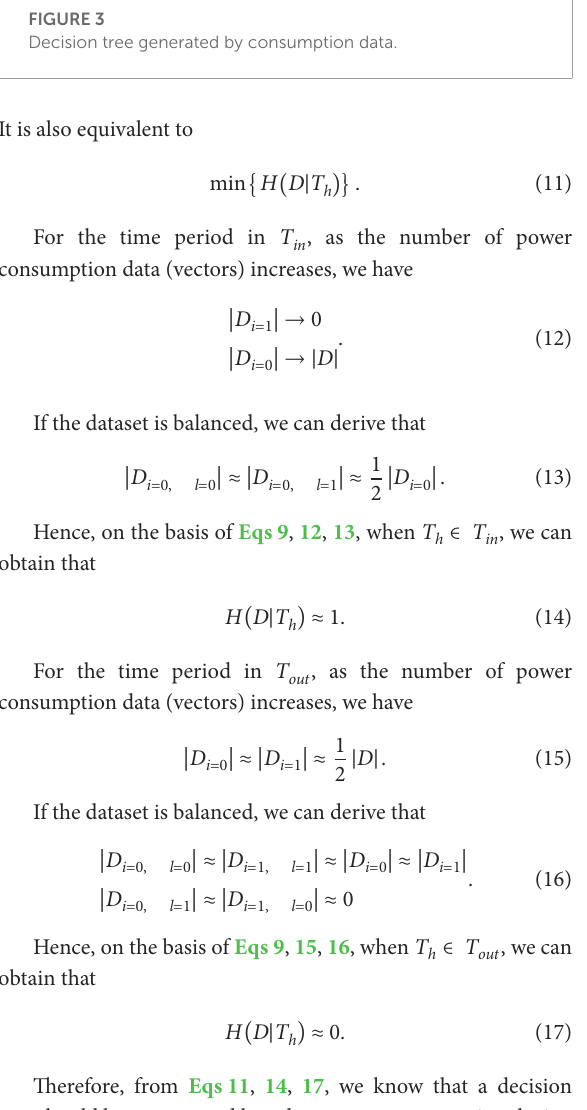
FIGURE 3 Decision tree generated by consumption